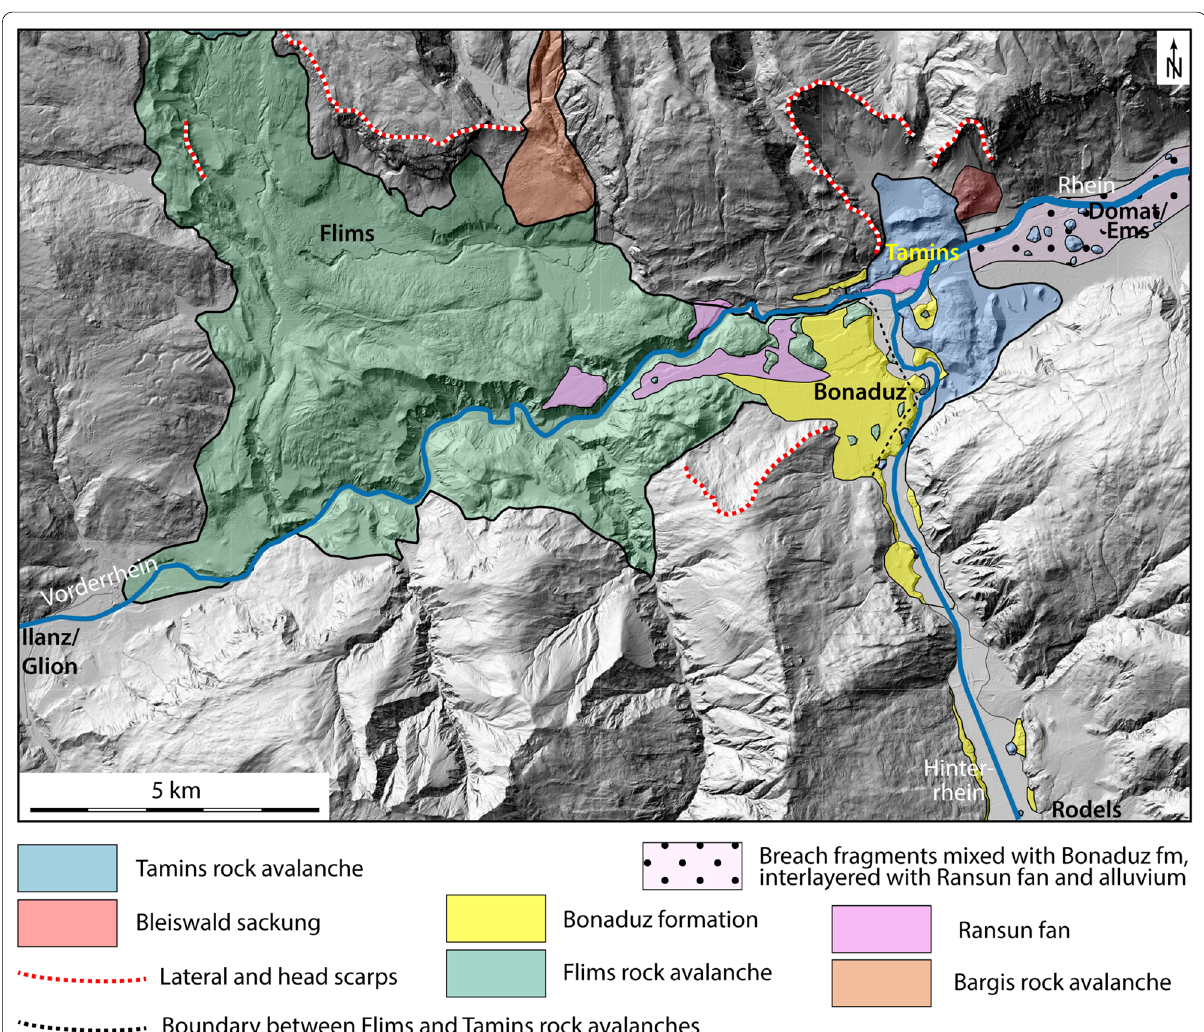
Fig. 1 Geographic setting of the Flims and Tamins rock avalanches and associated